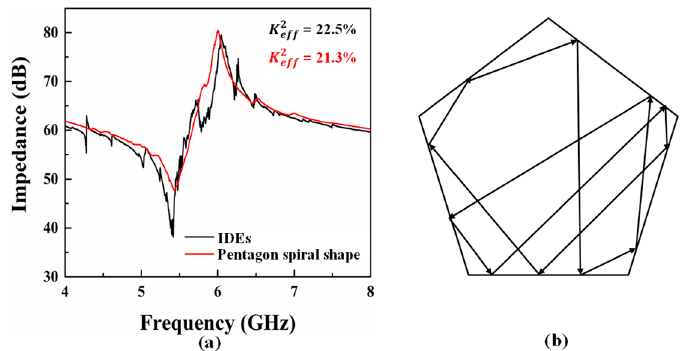
Figure 7. ( a ) The measured impedance curve of XBARs with IDTs structure (black) and pentagon spiral electrodes (red) vs. frequency, respectively. ( b ) Schematic diagram of acoustic wave propagation path in a pentagonal electrode.